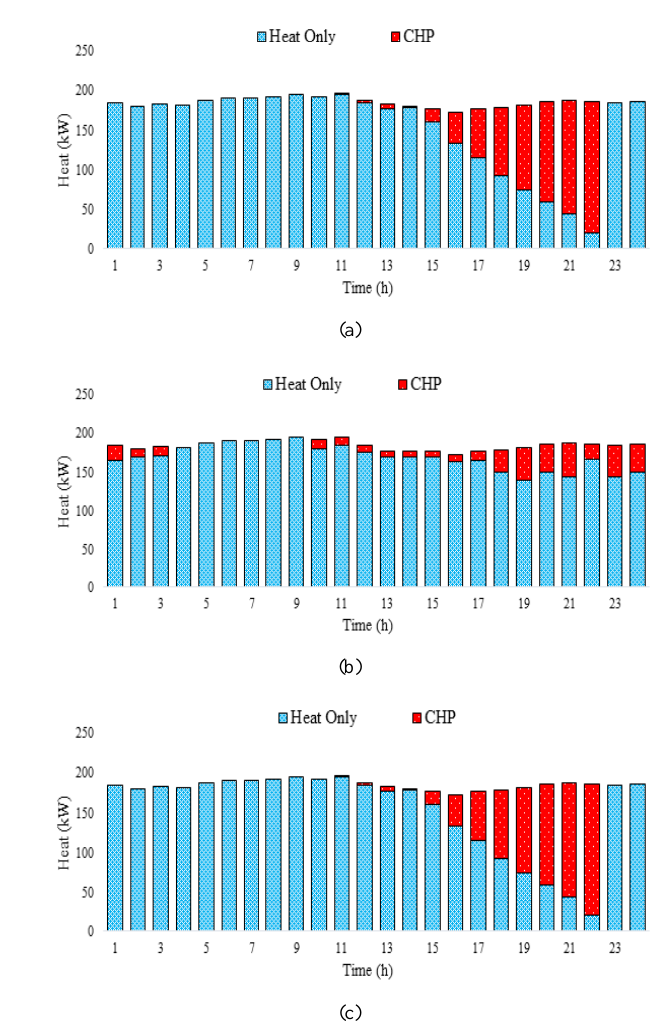
Fig. 7. Generated heat of CHP and heat only units, a) first case; b) second case; c) third